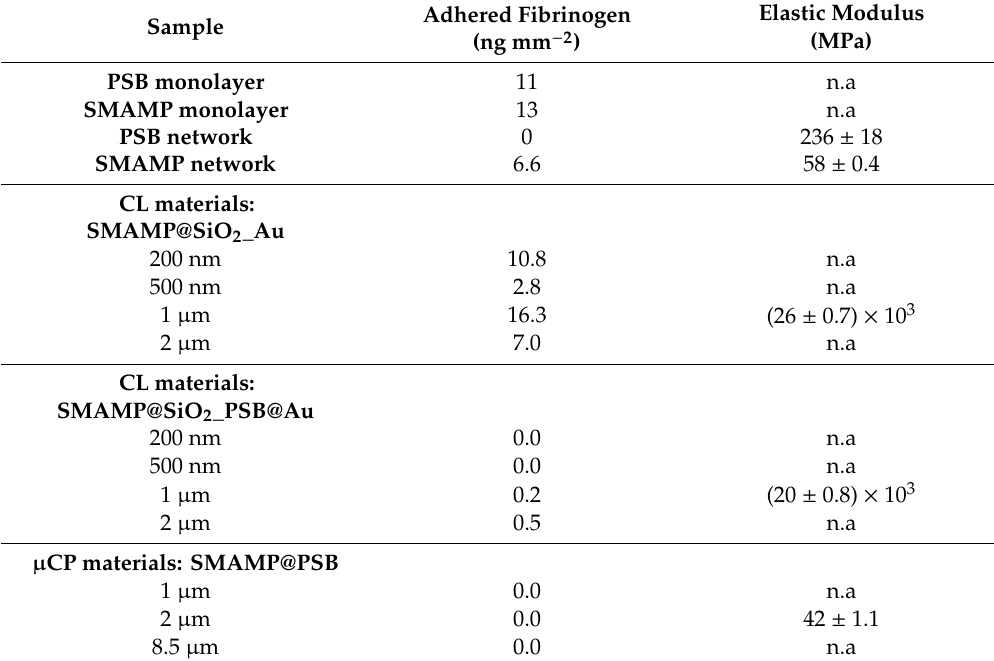
Table 1. Average amount of adhered fibrinogen (in ng mm − 2 ) on the di ff erent materials studied. Part of the data was previously reported